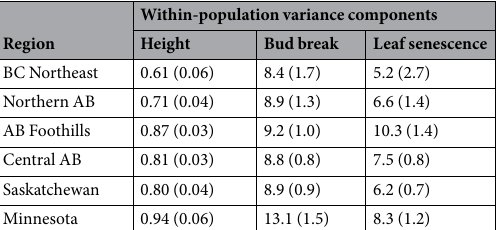
Table 1. Measured adaptive traits and residual variance components summarised by region. Standard errors (SE) in parentheses. Height measurements were taken at all five test sites. Bud break and leaf senescence was measured only at the central Alberta test